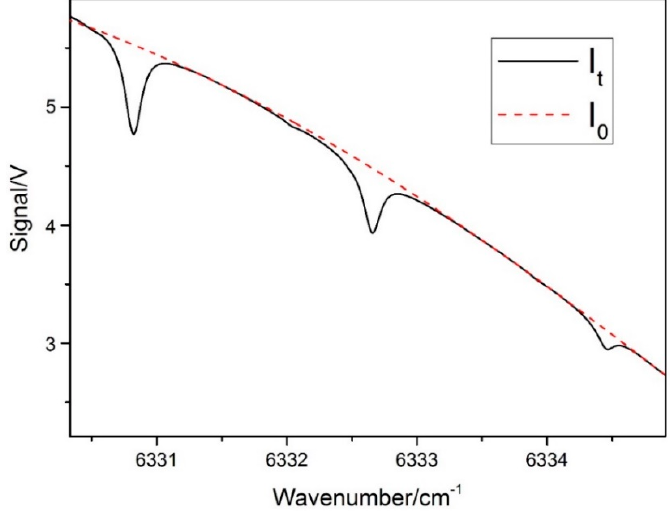
Figure 4. Direct absorption signals I t and baseline signal I 0 (T = 318 K, 10% CO 2 , L = 20 m).